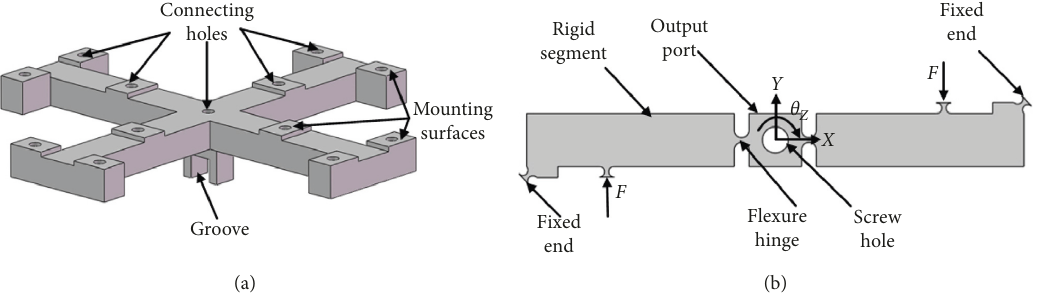
Figure 2: (a) Cruciform connecting structure and (b) nonuniform